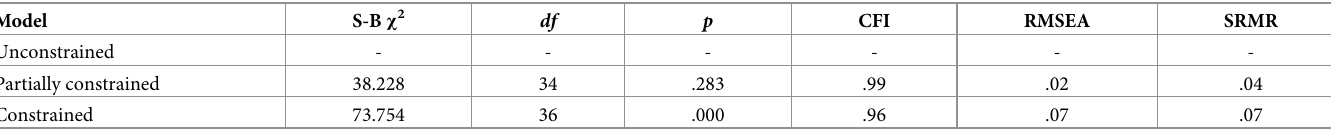
Table 5. Summary of fit statistics for the hypothesised multiple-group path model for intergroup context.